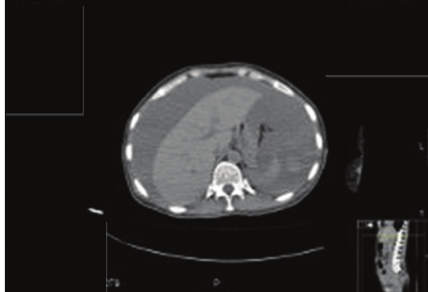
Figure 1: CT scan demonstrating significant intraperitoneal bleed-